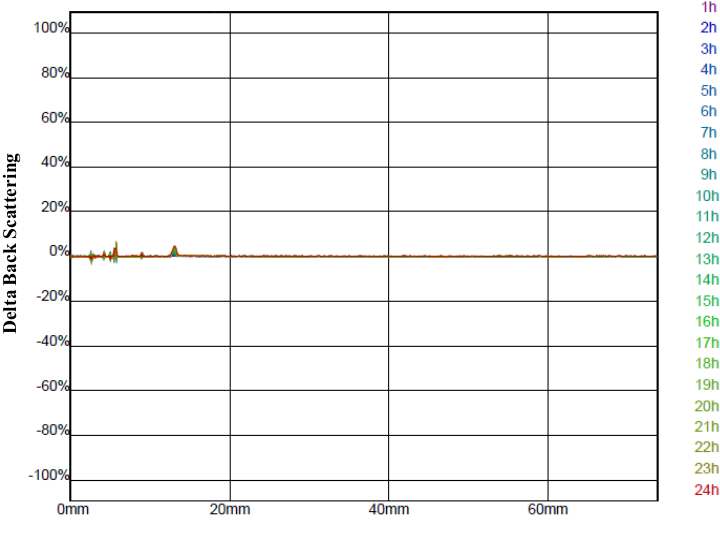
Figure 2. The delta back scattering profile measured every hour over 24 h for an infeed solution prepared with the encapsulating agents’ stock solution at 35% (w/w) and a ratio of 1.5:1 g/g of the aqueous bitter melon extract to the encapsulating agent solution. The graph is typical of the delta back scattering profile for all the other infeed solutions prepared with different concentrations and